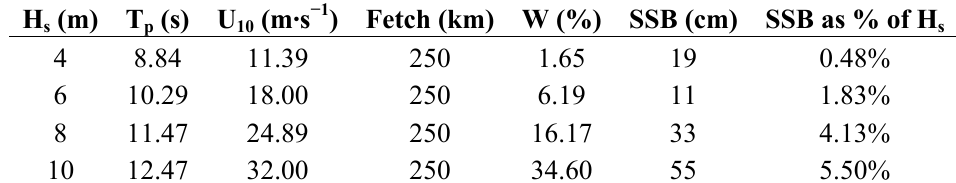
Table 1. Some values of Foam-Induced Sea State Bias (FISSB) as function of H speed U